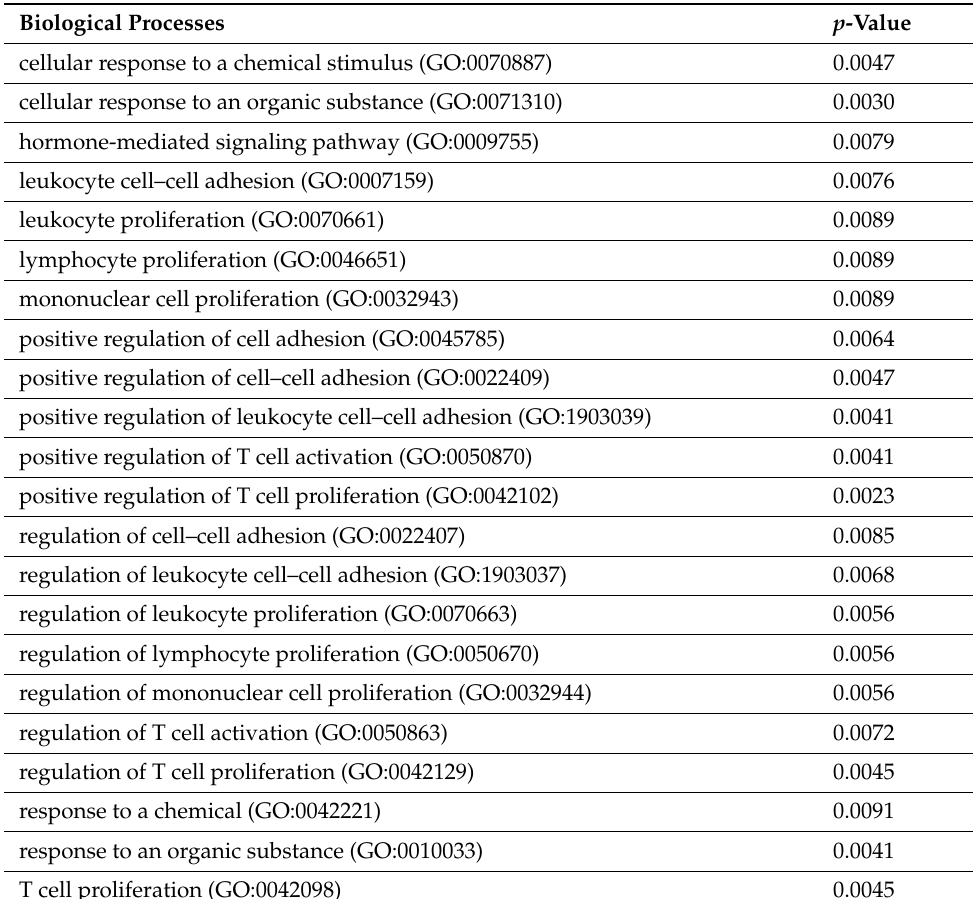
Table 3. The biological processes in which the differentially expressed genes are involved (PANTHER overrepresentation test, p <